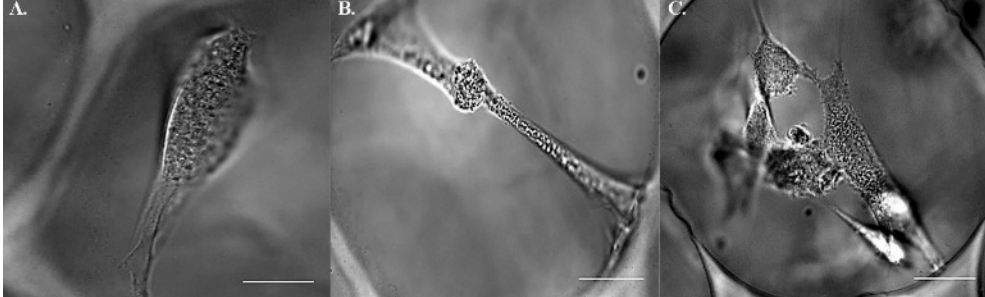
Figure 3. Heterogeneous morphologies of hMSCs indwelling 3D substrates. Bright field of hMSCs ( A ) vertically lying ( B ) bridging over ( C ) pyramidal-shaped. Scale bar = 20 µ m.